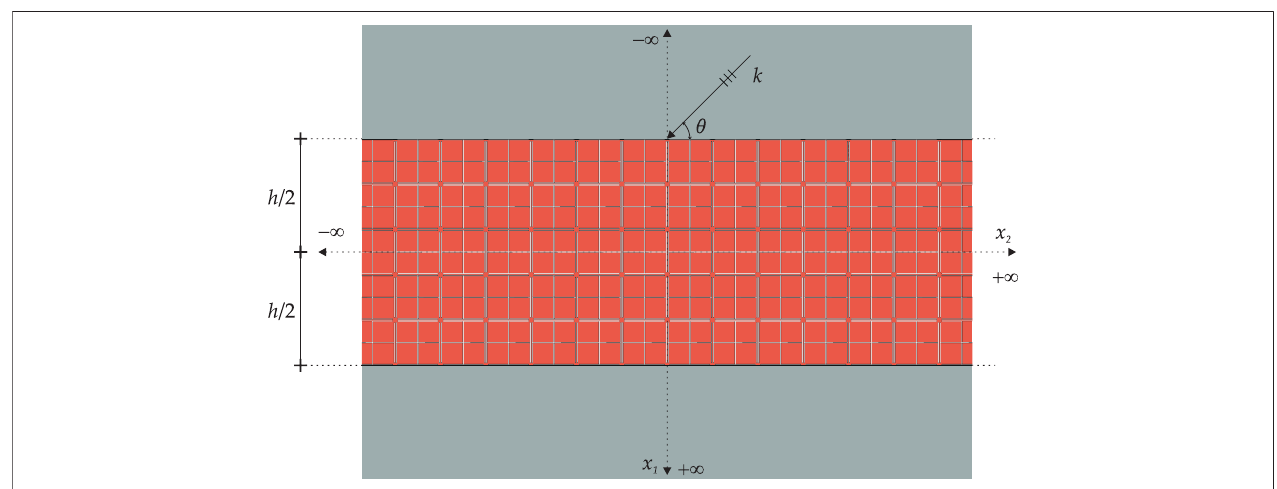
FIGURE 5 | Schematic representation of a wave with wavenumber k hitting at angle θ a microstructured material slab of thickness h embedded between two isotropic Cauchy media.